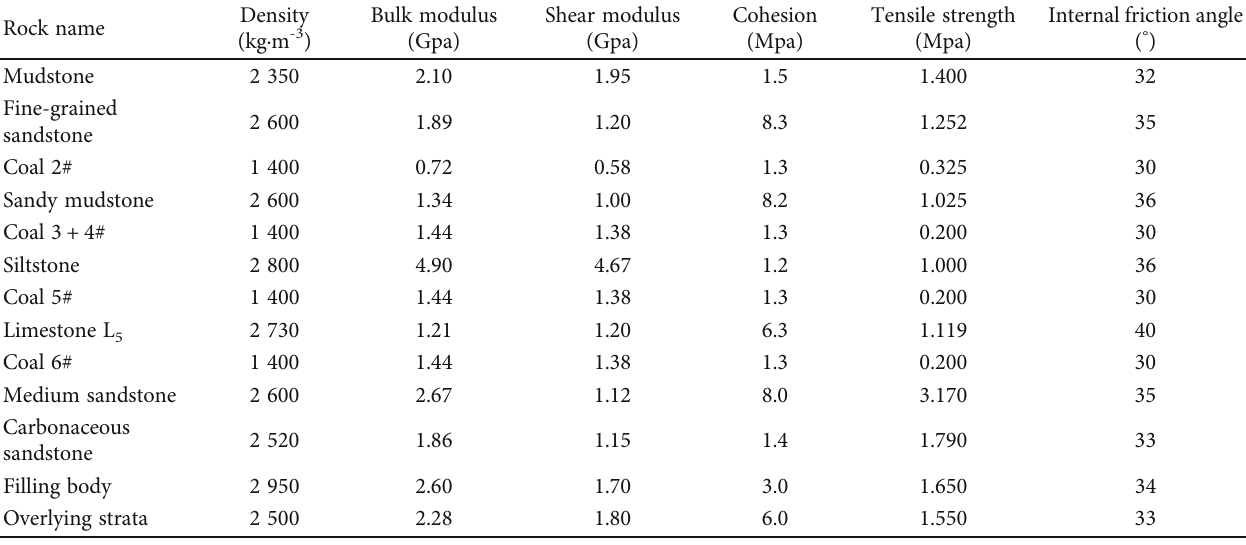
Figure 5: Numerical simulation model diagram. Table 1: Mechanical parameters of rock